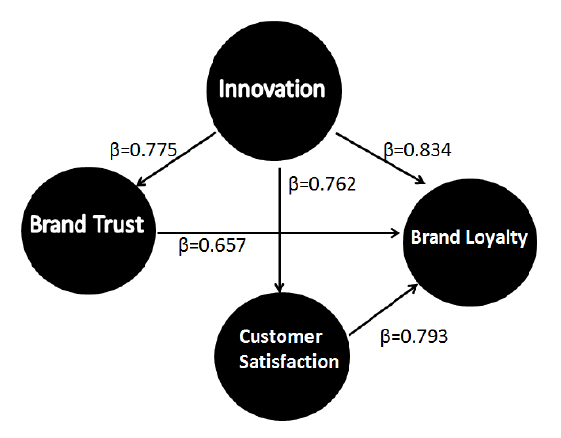
Figure 3. The Impact of Innovation on Brand Trust, Customer Satisfaction and Brand